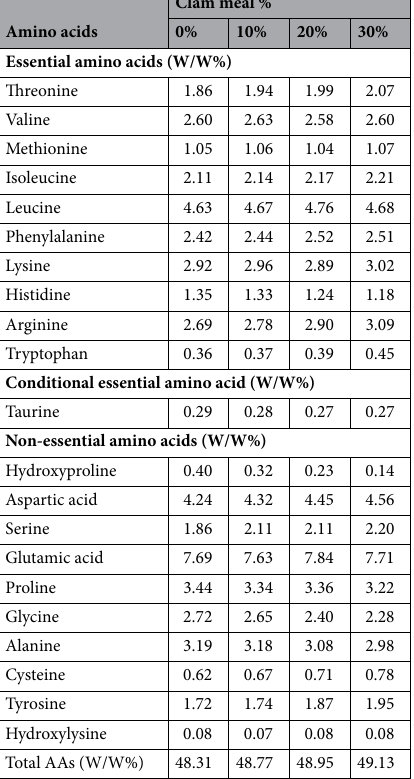
Table 2. Amino acid compositions of diets. Analyzed by the Experiment Station Chemical Laboratories (ESCL), University of Missouri, Columbia, MO 65211. Results are expressed on an "as is" basis unless otherwise indicated. W/W% = grams per 100 g of sample. Crude protein* = %N ×